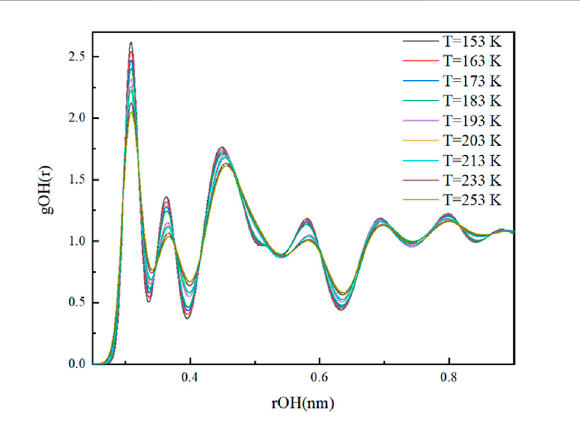
FIGURE 7 RDF of O-H at different